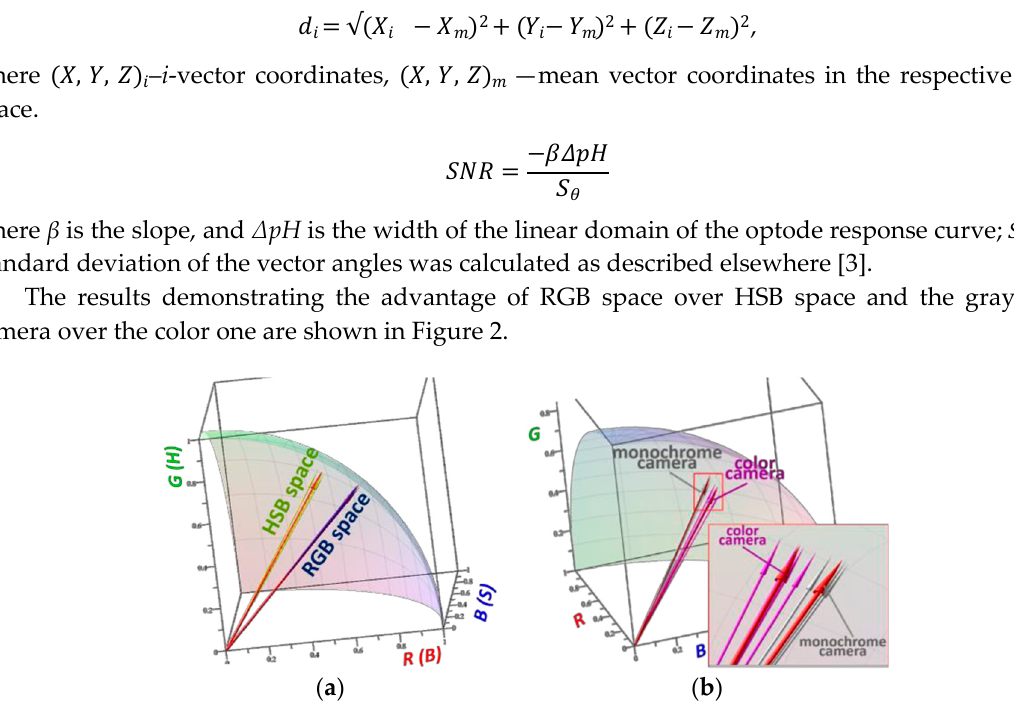
Figure 2. Deviation of the measured intensities from the median (red vectors): ( a ) for RGB and HSB color spaces (monochrome camera); ( b ) for color ( SNR = 33) and grayscale ( SNR = 58) cameras in RGB space. Optodes: indicator TPBE (120 mM/kg), pH 7.58.